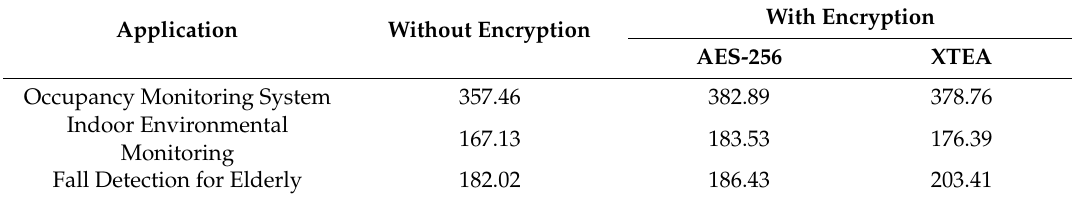
Table 6. Energy consumption of IoT applications with and without encryption for single data read and transmission.